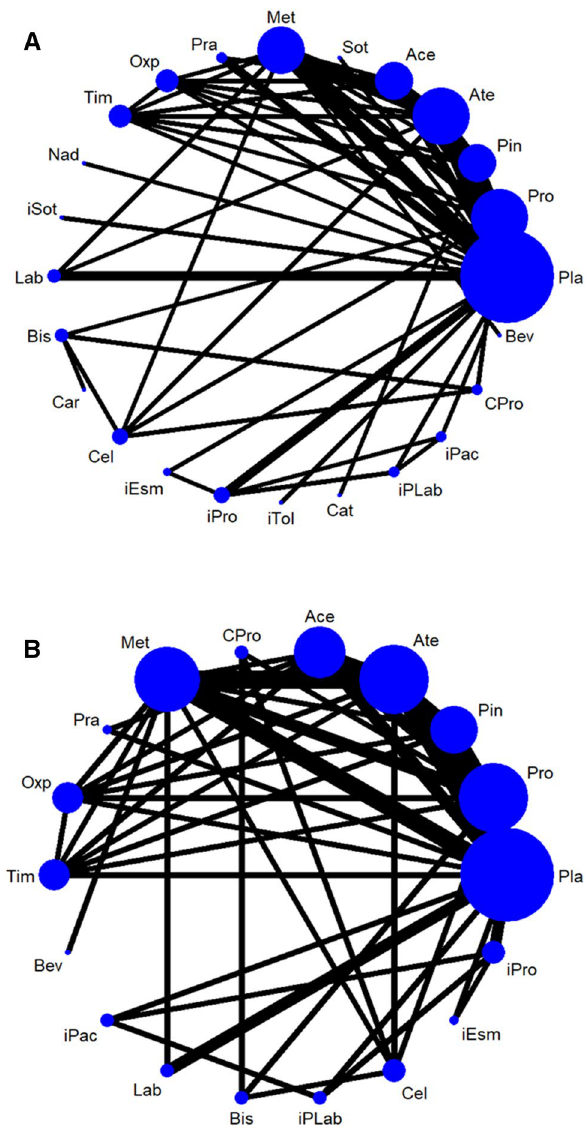
Figure 2. The network structure of ( A ) individual beta-blocking agents among the overall participants and ( B ) individual beta-blocking agents among participants with a baseline history of asthma. The lines between nodes represent direct comparisons in various trials, and the size of each circle is proportional to the size of the population involved in each specific treatment. The thickness of the lines is proportional to the number of trials connected to the network. Ace oral acebutolol, Ate oral atenolol, Bev oral bevantolol, Bis oral bisoprolol, Car oral carvedilol, Cat oral carteolol, Cel oral celiprolol, CI confidence interval, CPro oral celiprolol and propranolol, iEsm infusion of esmolol, iPac infusion of practolol, iPLab infusion of propranolol and labetalol, iPro infusion of propranolol, iSot infusion of sotalol, iTol infusion of tolamolol, Lab oral dilevalol or oral labetalol, Met oral metoprolol, Nad oral nadolol, Oxp oral oxprenolol, Pin oral pindolol, Pla Placebo/control, Pra oral practolol, Pro oral propranolol, Sot oral sotalol, Tim oral